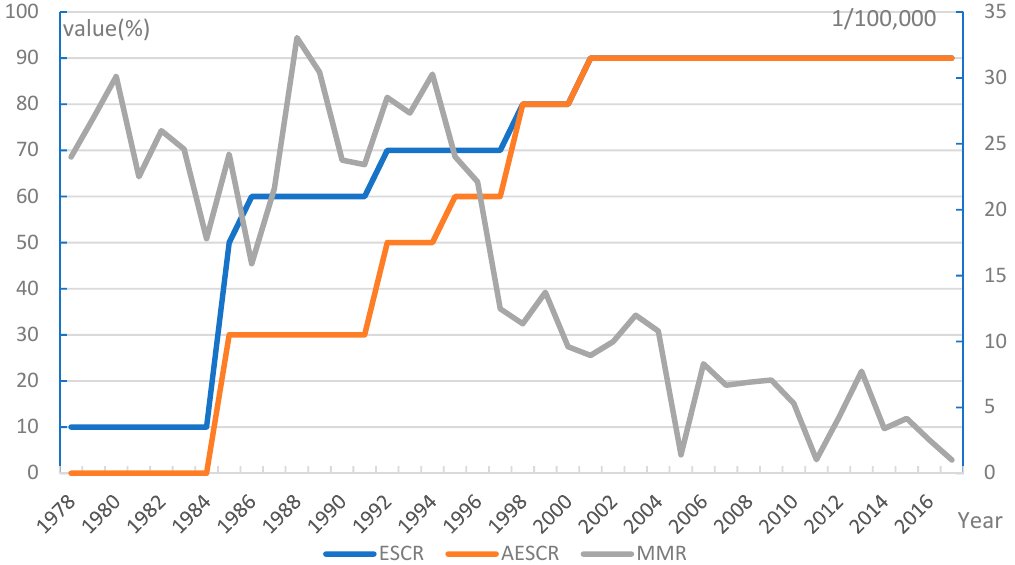
Figure 1. Trends of MMR, ESCR, and AESCR in SH. SH has introduced policies for 9 categories of essential WHSs (i.e., all except menopause care services). All these services have corresponding assessment indicators or assessment criteria. MMR: Maternal mortality ratio; ESCR: The essential maternal healthcare service coverage rate; AESCR: The assessable essential healthcare service coverage rate; SH: Shanghai; WHSs: Women’s healthcare services.